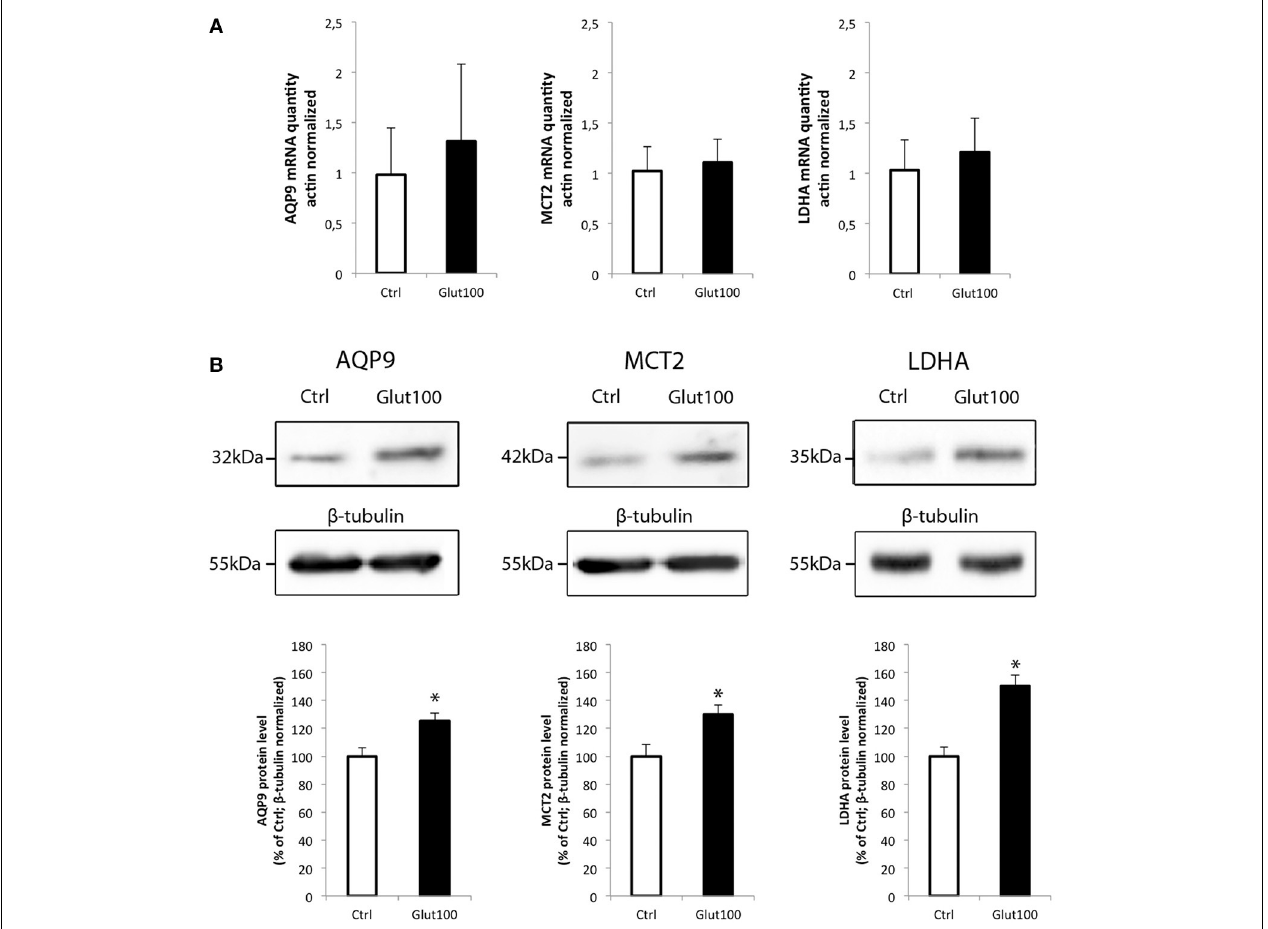
FIGURE 4 | Effect of glutamate on mRNA and protein expression of AQP9, MCT2, and LDHA in cultured rat hippocampal neurons (A) Primary cultures of rat hippocampal neurons were treated with glutamate 100 µ M for 1h. Then mRNA was extracted and analyzed for AQP9, MCT2 and LDH mRNA expression using RT-PCR. Results are expressed as relative expression vs. control with mean value for control set at 1 after values had been normalized using β -actin as internal reference. Results represent mean ± SD with n = 3. The experiment was repeated three times from different cultures with similar results. Statistical analysis was performed using a non-parametric Mann–Whitney test. No significant difference was observed. (B) Primary cultures of